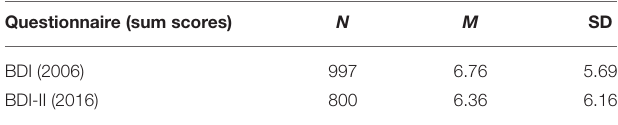
TABLE 3B | Questionnaire scores BDI (2006) and BDI-II (2016).